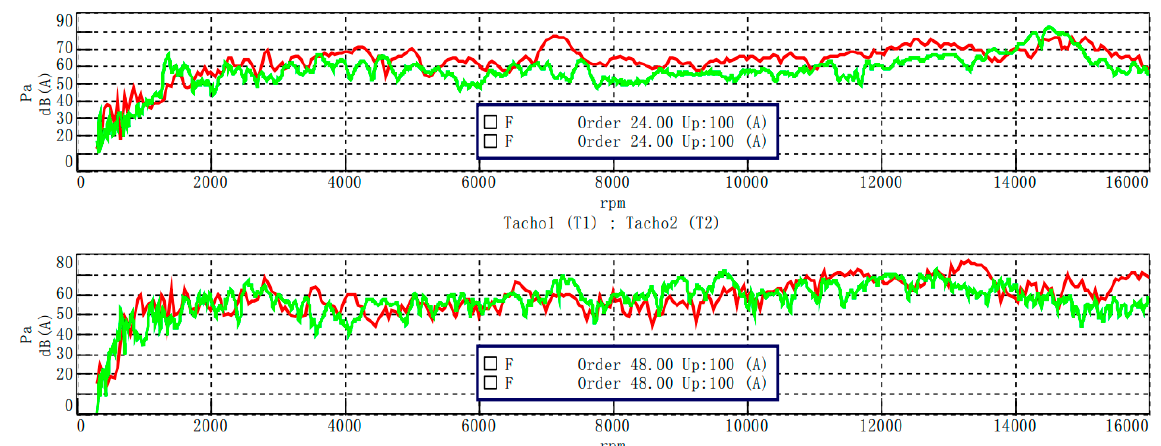
Figure 17. Motor noise tested at 50% energy